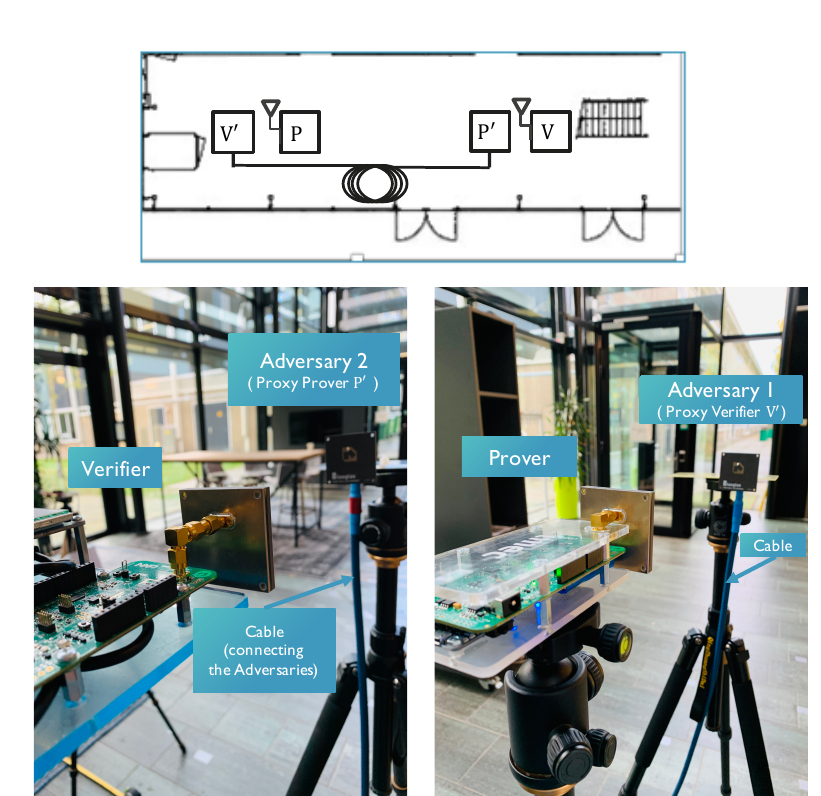
Figure 19: The relay attack model setup and the layout of the indoor environment in which the model is set up.